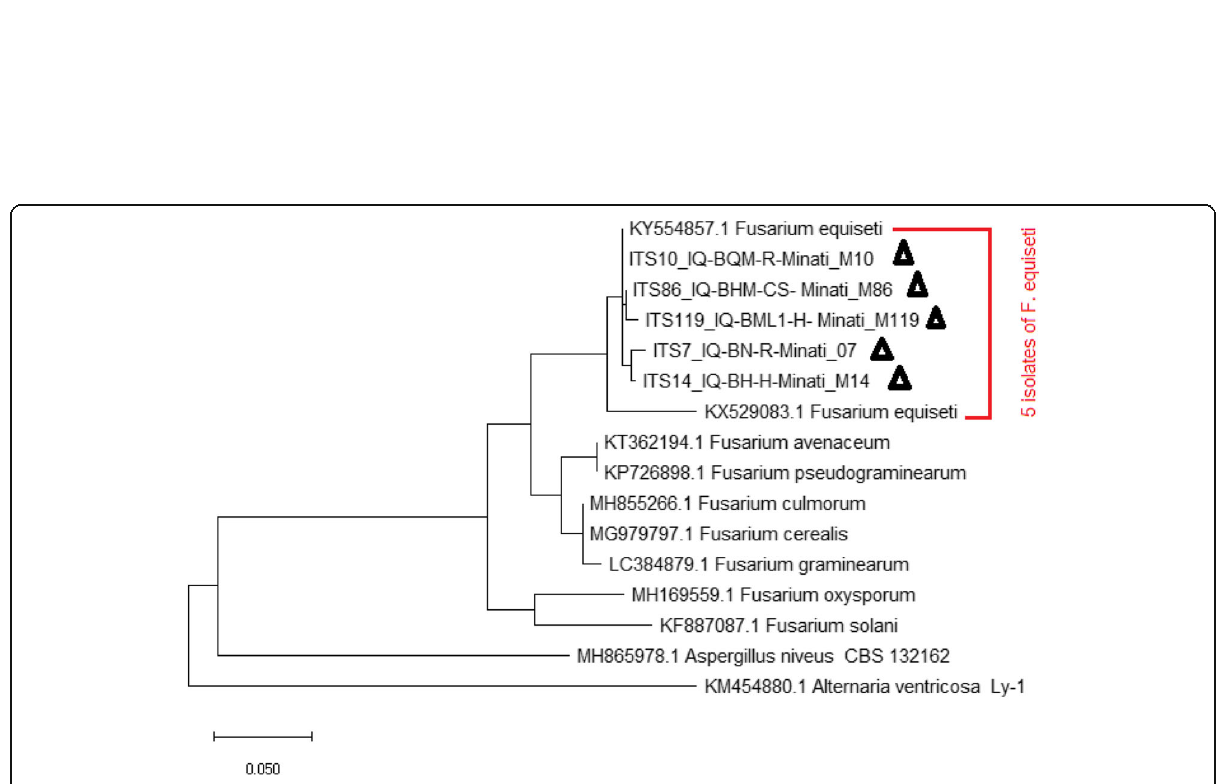
Fig. 5 Phylogenetic tree generated with the ITS-rDNA sequences of the Fusarium equiseti (5), as inferred from the maximum likelihood (ML) analyses (determined by black triangles) and related species retrieved from GenBank. ITS sequences of Aspergillus niveus (MH865978) and Alternaria ventricosa (KM454880) were used as the out-group species